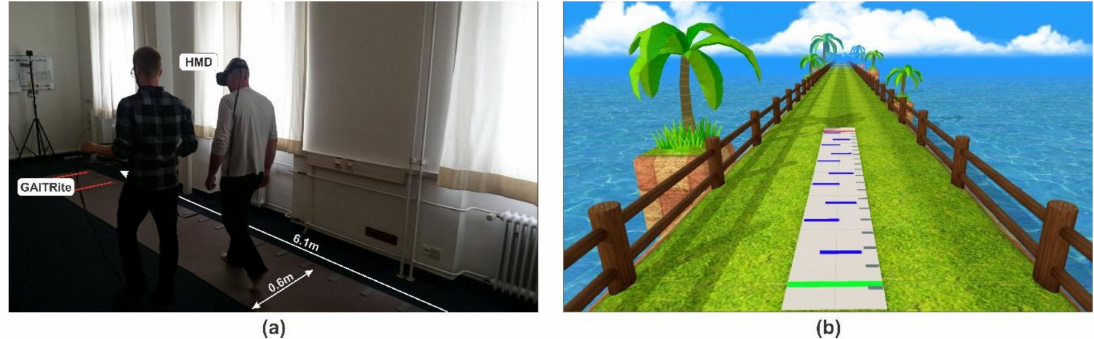
Figure1. Experimentalsetup: ( a )Aparticipantwalksintherealworkspacewithahead-mounteddisplay (HMD) over the GAITRite ® walking surface. ( b ) Participant’s view of the virtual environment on the HMD. The walkway in the virtual environment exactly matched the real GAITRite ® system